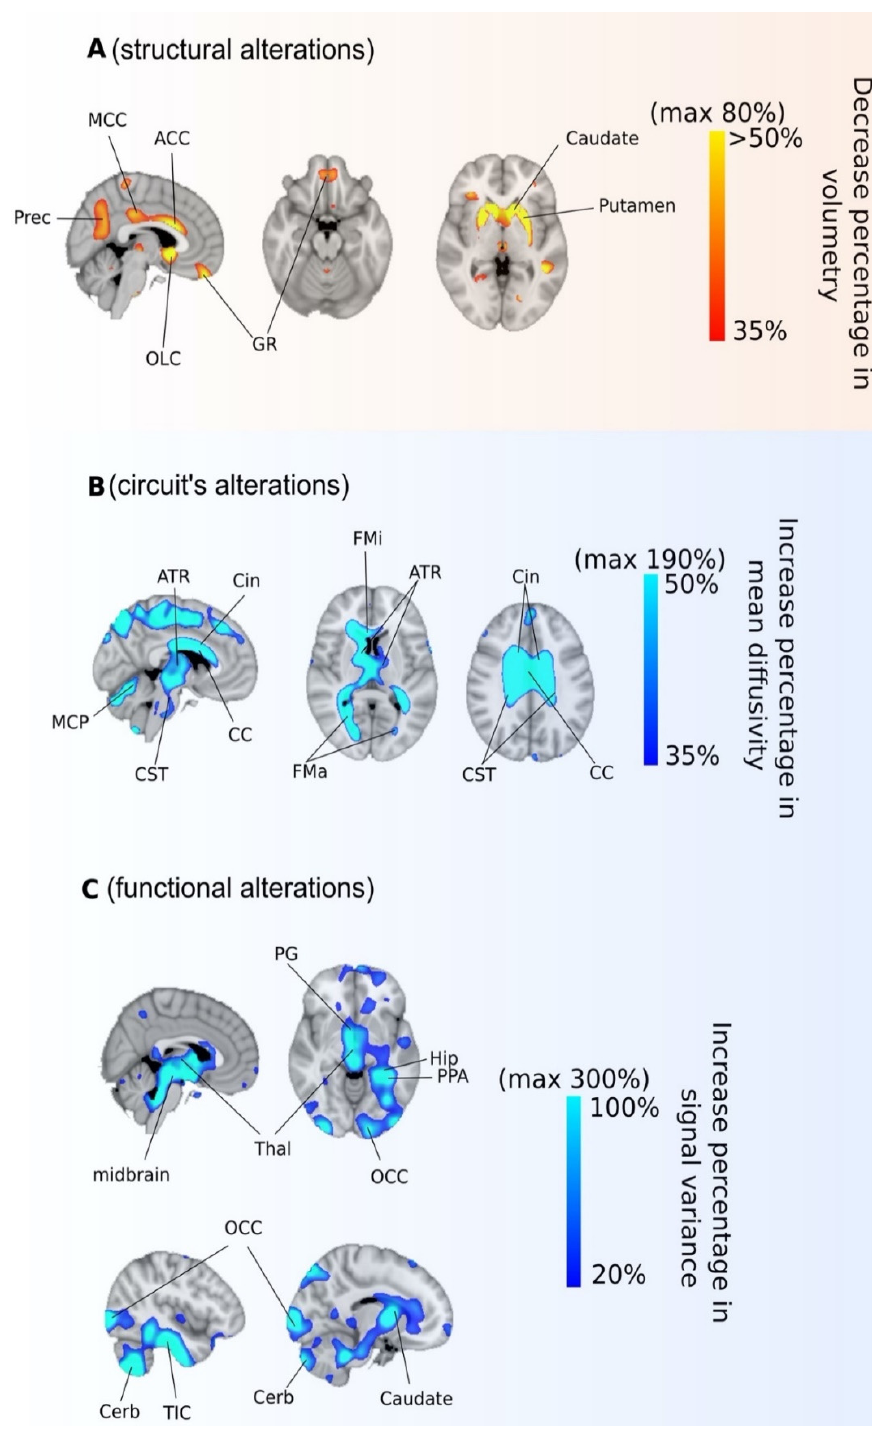
Figure 3. Morphological, circuits’, and functional alterations in combined Cobalamin D disorder. Three different MRI acquisitions and analyses provided three different classes of alterations: ( A ) structural; ( B ) circuits’; ( C ) functional. Abbreviated labels are OCC: Occipital cortex; Cerb: Cerebellum; TIC: Temporal inferior cortex; Hip: Hippocampus; Thal: Thalamus; PPA: Parahippocampal; Prec: Precuenus; GR: Gyrus rectus; CC: Corpus callosum; MCC: Midcingulate cortex; ACC: Anterior cingulate cortex; OLC: olfactory cortex; PG: pale globe; MCP: middle cerebellar peduncle; CST: cortico-spinal tract; ATR: anterior thalamic radiation; Cin: cingulum; FMa: forceps major; FMi: forceps minor. Orange and blue colors indicate respectively patient < control and patient > control.